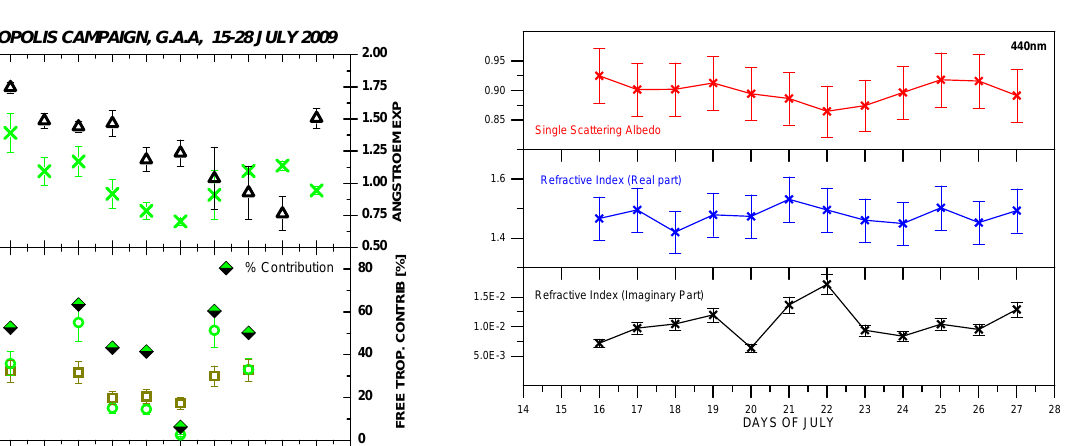
Fig. 2. Top: Single scattering albedo ( ω) ; middle and lower panels, respectively: real and imaginary part of refractive index ( m ) mea- sured by sun photometer at 440nm over Athens for the time period 15–27 July